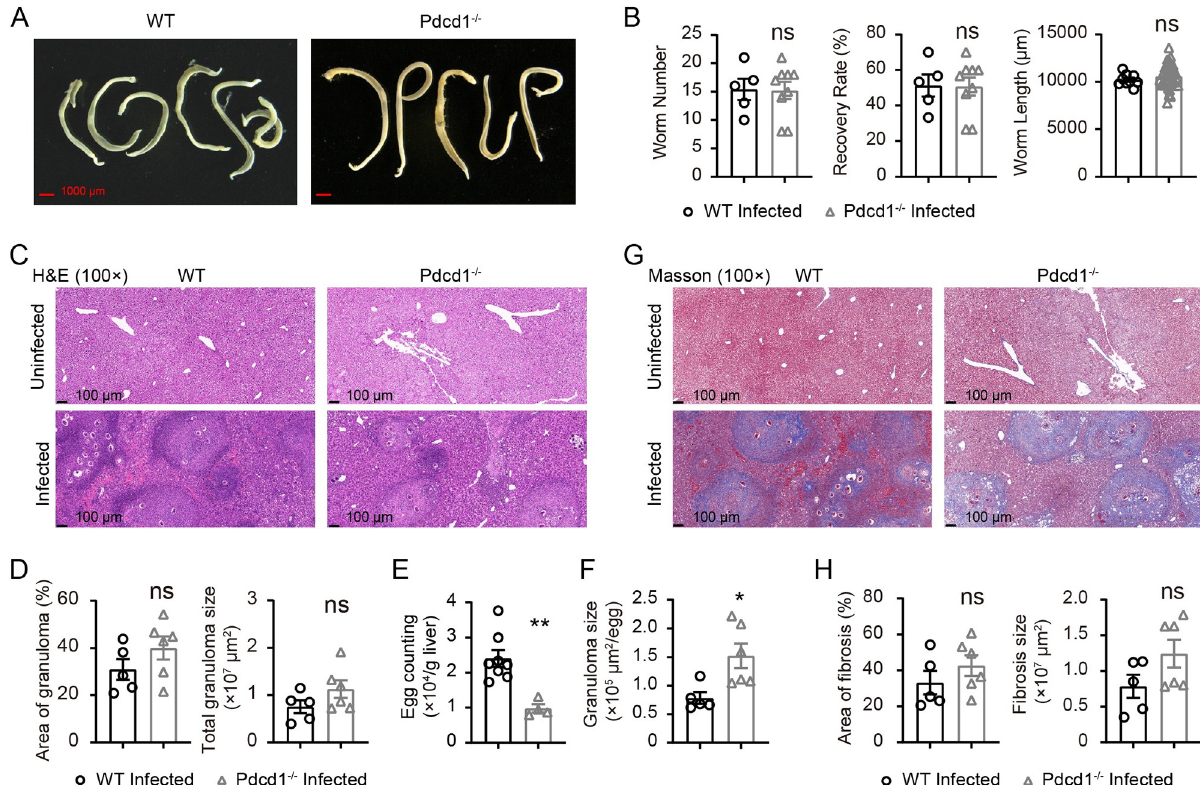
Fig 4. PD-1 deficiency does not significantly impact the pathogen load and pathology following S . japonicum infection. (A) Representative micrographs of adult S . japonicum parasites collected from portal and mesenteric veins of WT B6 mice using pump flush (left) and PD-1-deficient mice (right) 8 weeks after S . japonicum infection (scale bar, 1000 μ m). (B) Number of worms, and recovery rate were compared between worms collected from WT B6 mice and PD-1-deficient mice 8 weeks after S . japonicum infection (WT mice, n = 5; KO mice, n = 9). Parasite length were compared between the same two groups of mice, namely WT infected and KO infected mice (worms from WT mice, n = 9; worms from KO mice, n = 36). (C-D) H&E staining of liver sections to compare granuloma between WT control mice (left) and PD-1-deficient mice (right) 8 weeks after S . japonicum infection (scale bar, 100 μ m), and statistic comparisons of granuloma areas and sizes (WT mice, n = 5; KO mice, n = 6). (E) Counting of eggs in each gram of liver in WT control mice and PD-1-deficient mice 8 weeks after S . japonicum infection (WT mice, n = 8; KO mice, n = 4). (F) The granuloma size counted on the basis of single eggs in the H&E stained sections of the livers from WT control mice and PD-1-deficient mice 8 weeks after S . japonicum infection (WT mice, n = 5; KO mice, n = 6). (G-H) Masson staining of liver sections to compare liver fibrosis between WT B6 mice (left) and PD-1-deficient mice (right) 8 weeks after S . japonicum infection (scale bar, 100 μ m), and statistic comparisons of fibrosis severity (WT mice, n = 5; KO mice, n = 6). For histological analyses, each data point was calculated from an independent animal. Data represent the mean ± s.e.m. Statistical significance was assessed by unpaired Student’s t -test or non-parametric unpaired Mann-Whitney test and indicated by ns, non-significant.